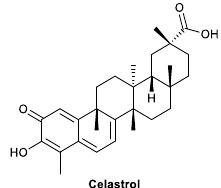
Figure 4. Structure of celastrol.